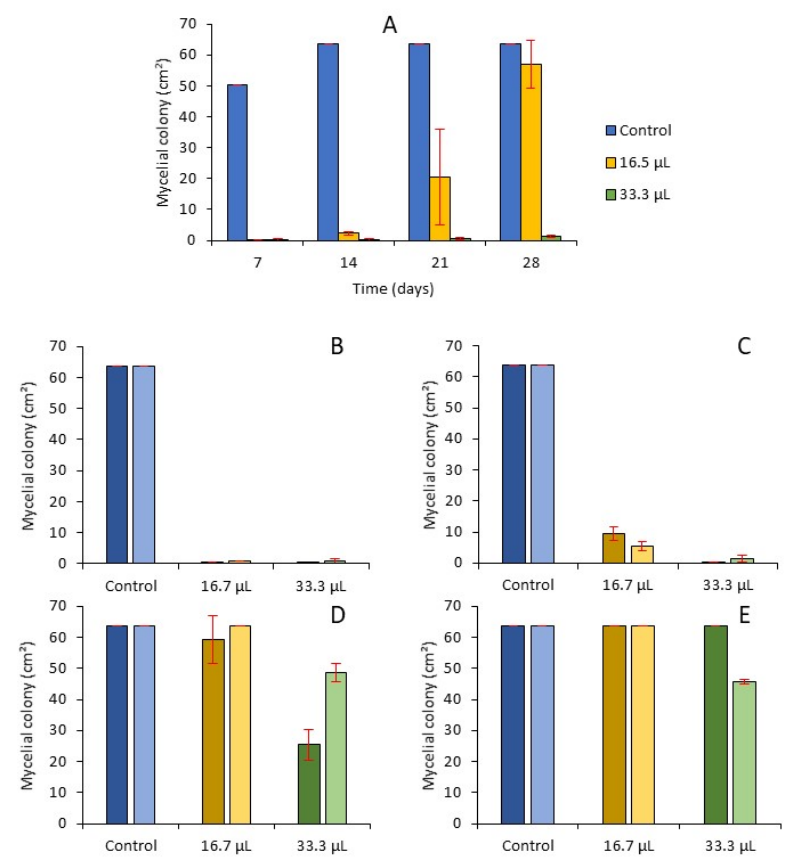
Figure 3. Mycelial growth of F. avenaceum in presence of volatile compounds from 16.7 or 33.3 µL EO L − 1 in consecutive cultures. ( A ) First exposure to volatiles. ( B , C ) second exposure with the same quantity of EO as in the first exposure of fungal material coming from ( A ) as spore suspension (dark bars) or plugs (light bars) (second culture-EO). ( D , E ) second culture without EO of fungal material coming from ( A ) as spore suspension (dark bars) or plugs (light bars); µL are those of the first exposure (second culture-control). ( B , D ) are measures at 10 days, ( C , E ) are measures at 28 days. Means of 3 replicates. Error bars are ± standard deviations.